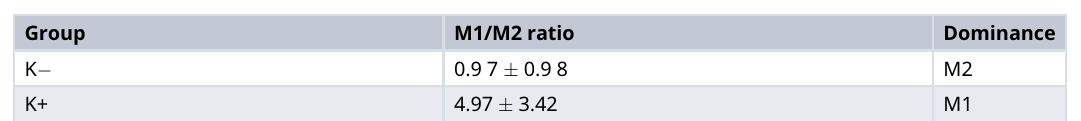
Table 3. Summary of M1/ M2 ratios for K (cid:2) and K+ groups.